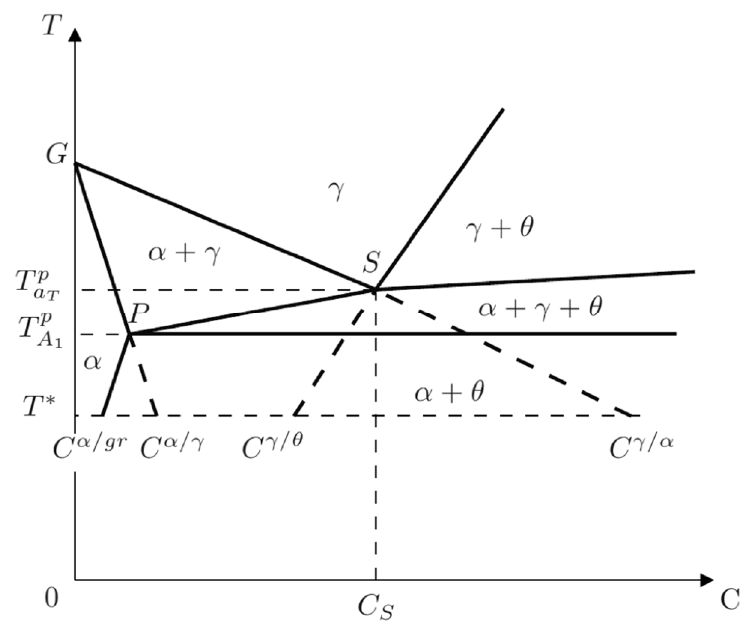
Figure 1. Fe-C binary isopleth section of the Fe-C-Si equilibrium phase diagram.